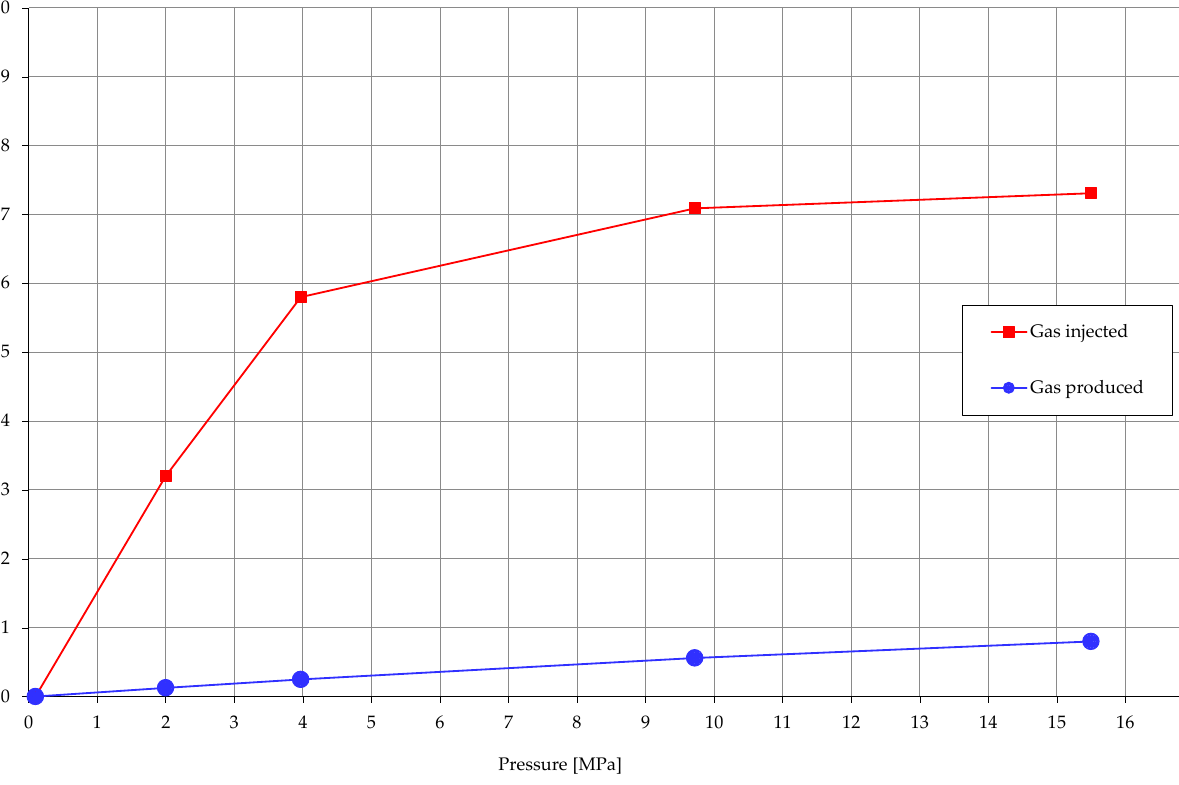
Figure 8. Solubility of gases in Borz ę cin reservoir water.